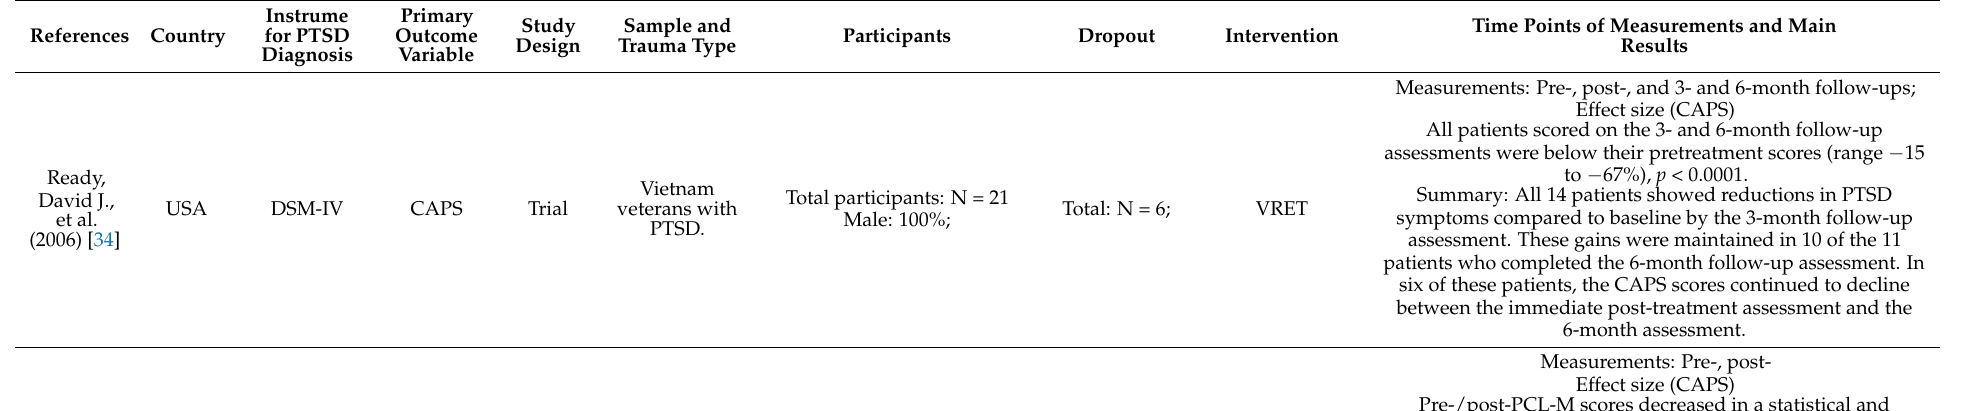
Table 1. Descriptive characteristics = 11 included